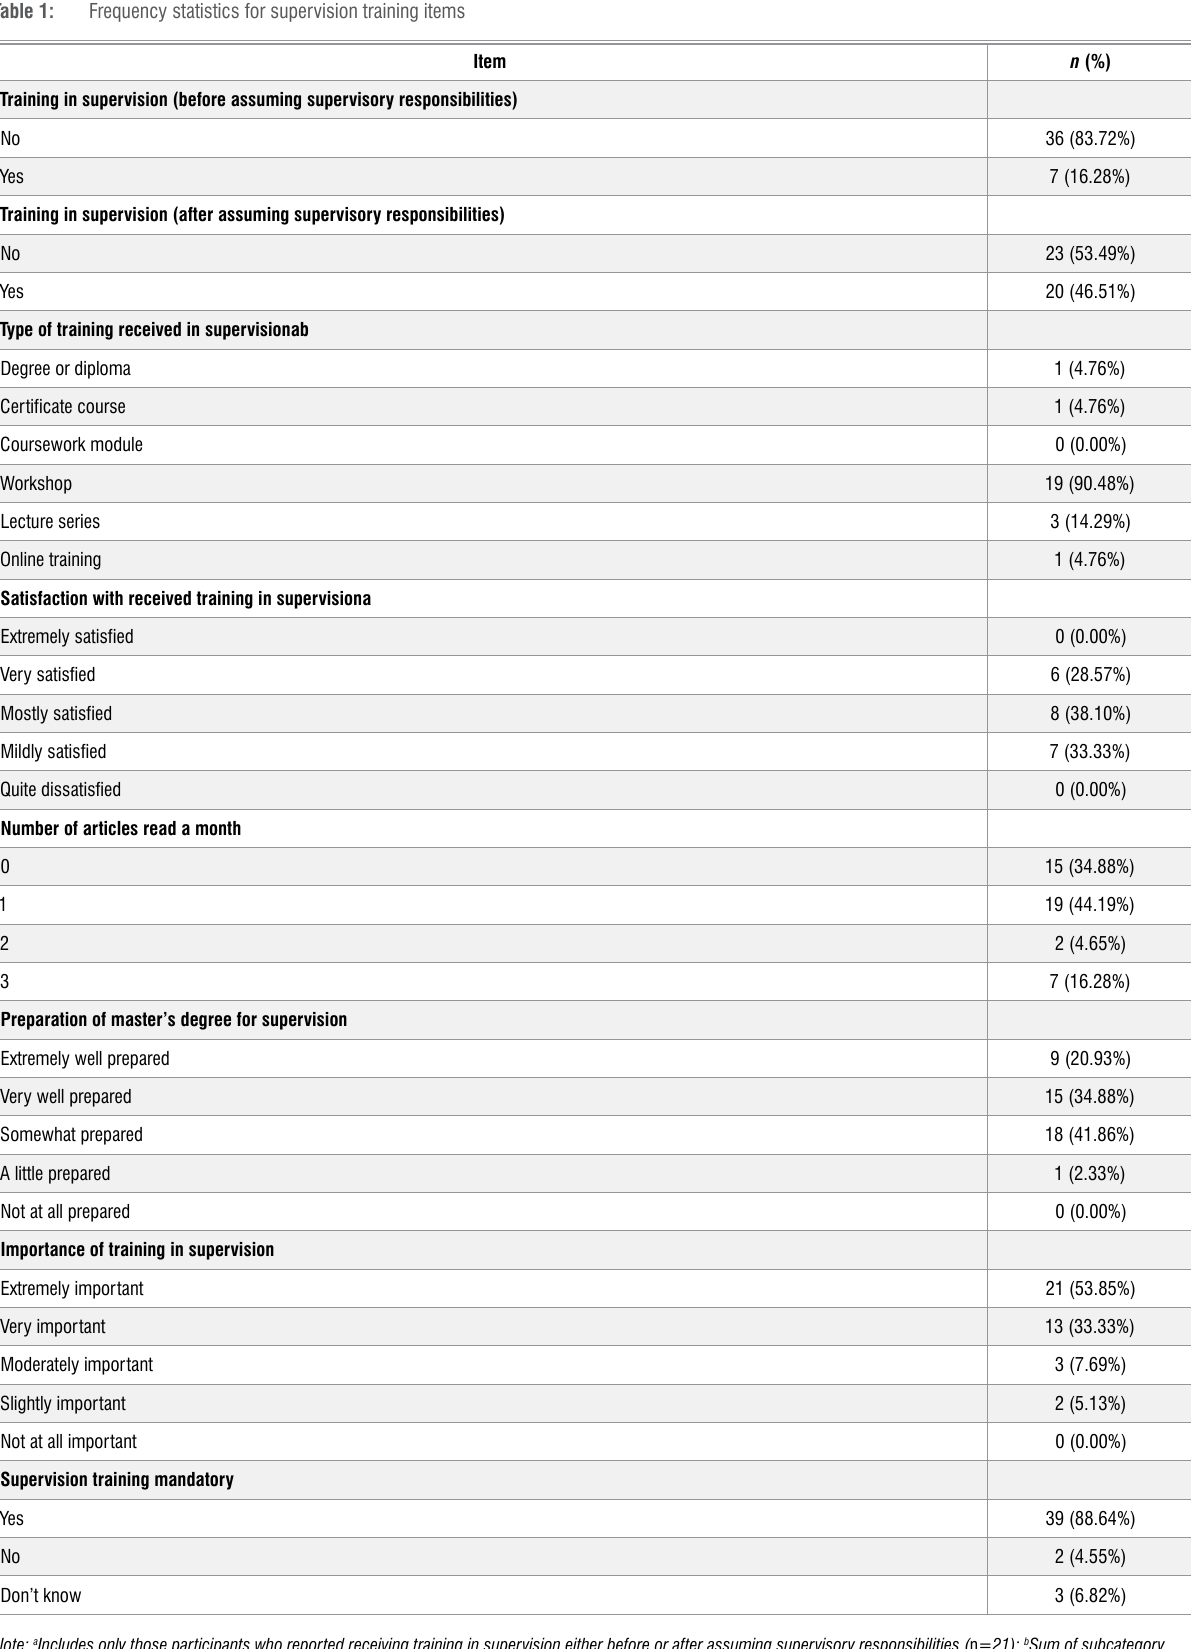
Frequency statistics for supervision training items